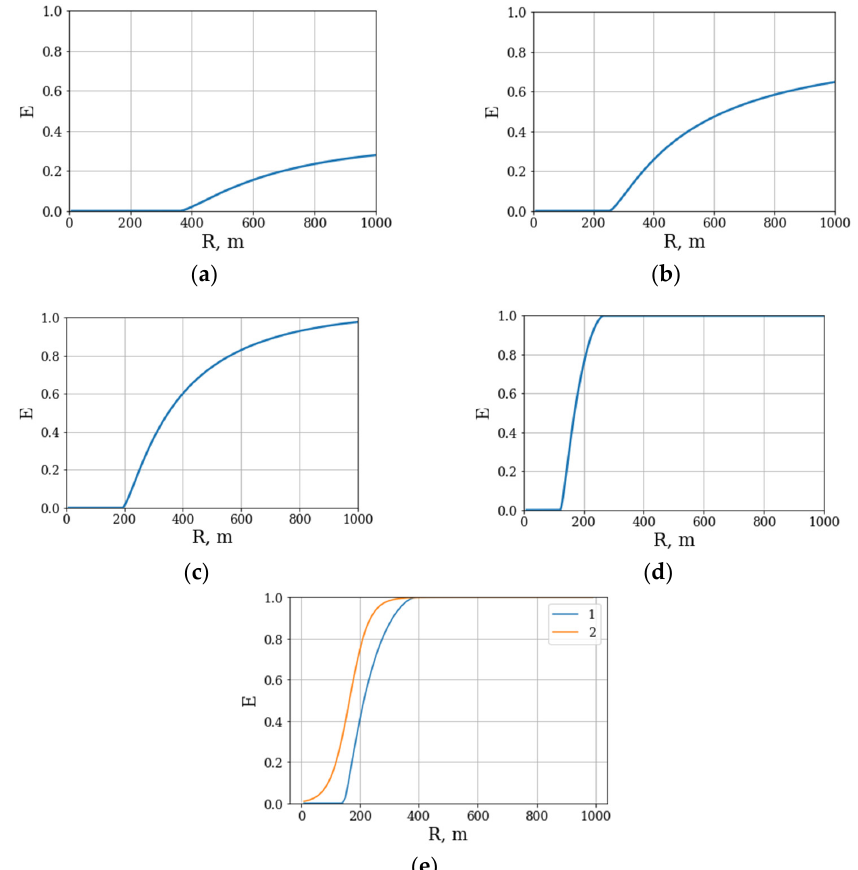
Figure 9. Geometrical function (E) of the lidar accounting for the input parameters from Table 2 for a photodetector with the photosensitive area ( a ) 0.1, ( b ) 0.3, ( c ) 0.5, ( d ) 1 and ( e ) 0.8 mm